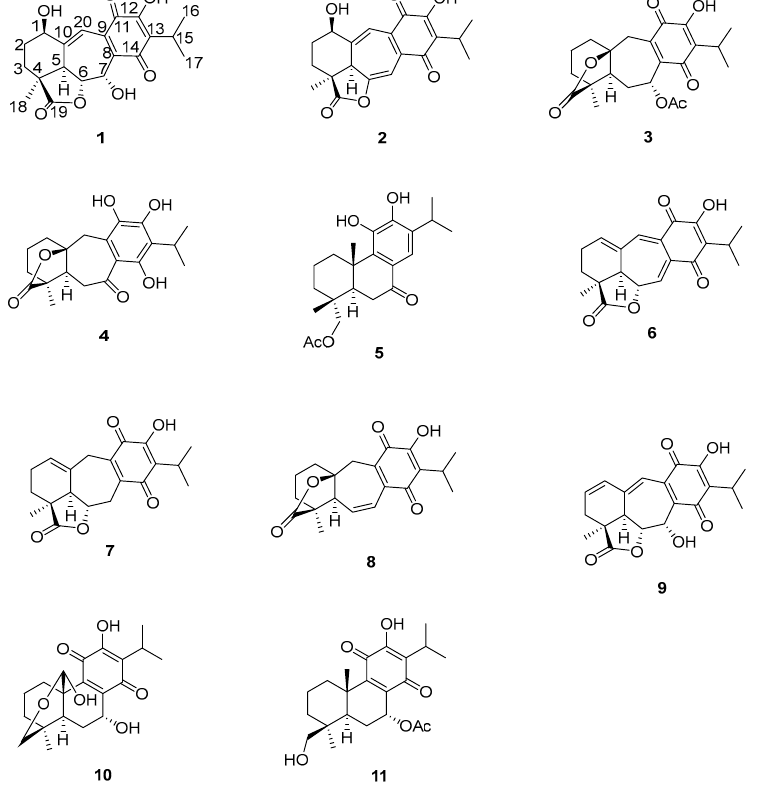
Figure 1. Chemical structures of 1 – 11 .